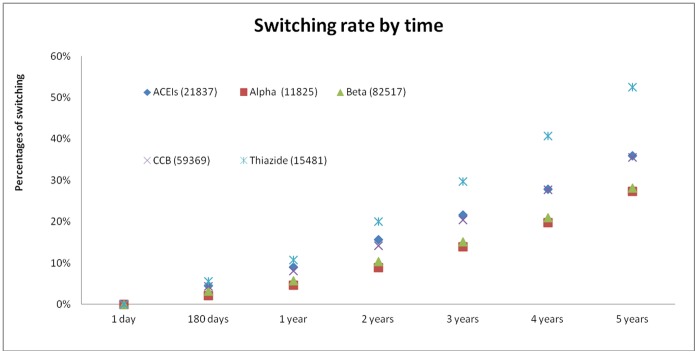
5-year cumulative switching rates of antihypertensive drugs according to medication class.